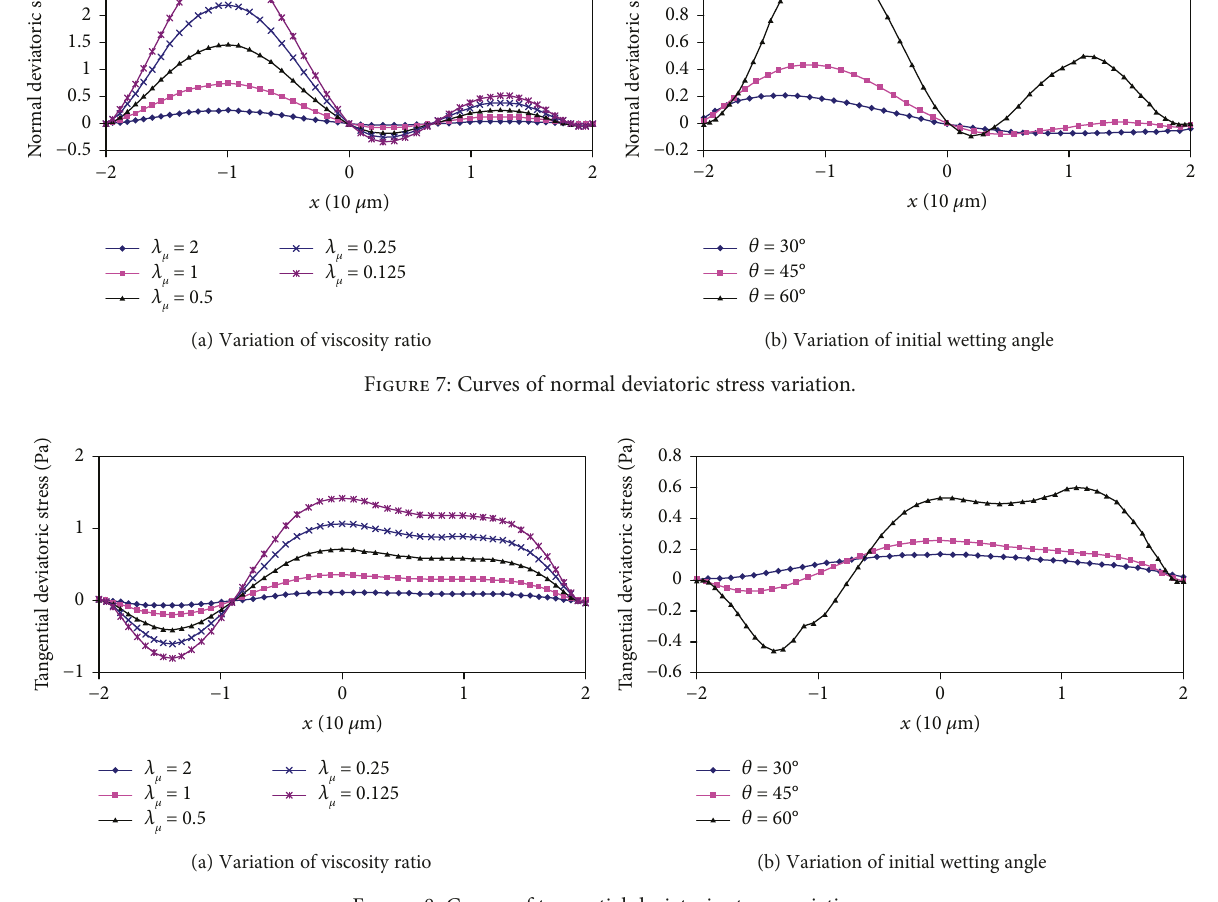
Figure 8: Curves of tangential deviatoric stress variation.